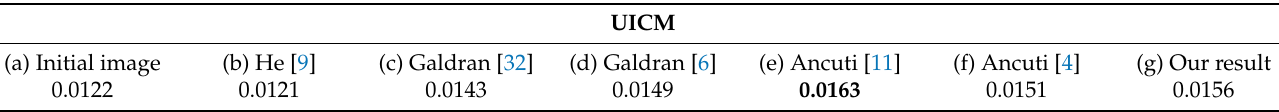
Table 1. Underwater image color restoration evaluation based on the UICM metric; the larger the metric, the better the resolution.